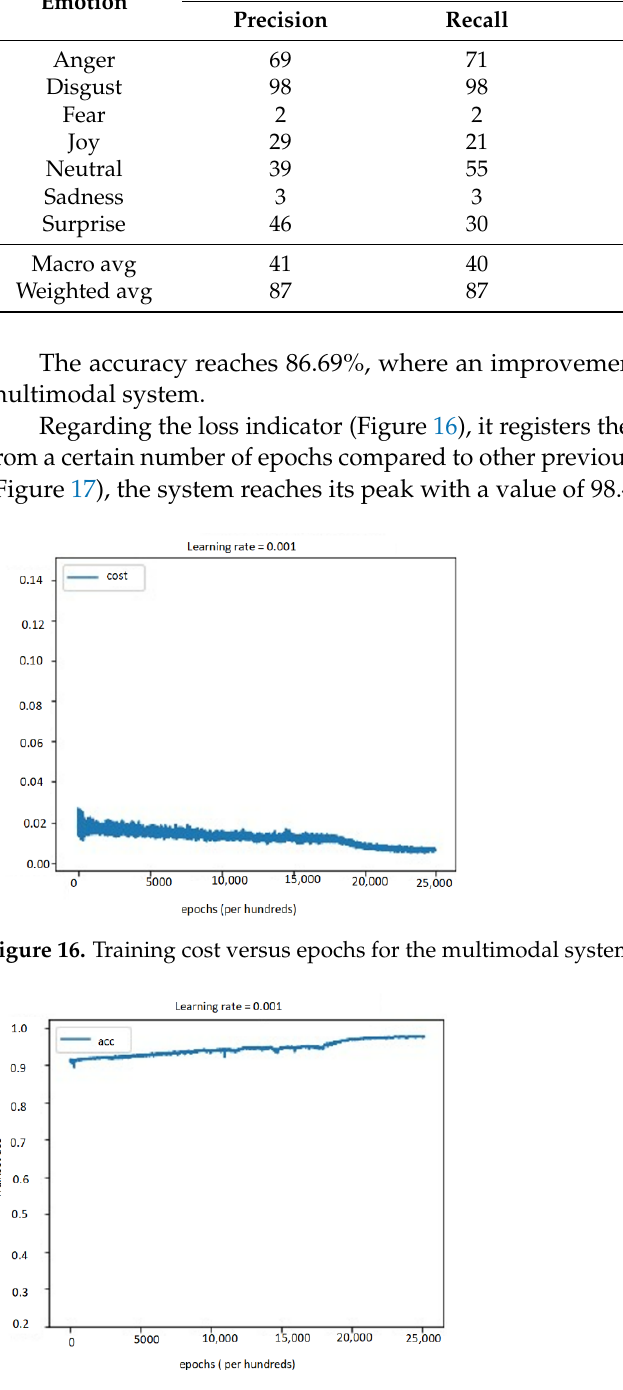
Figure 17. Training accuracy versus epochs for the multimodal